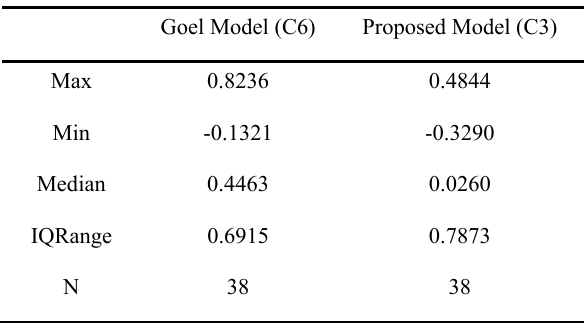
Table 3. Measurements of the